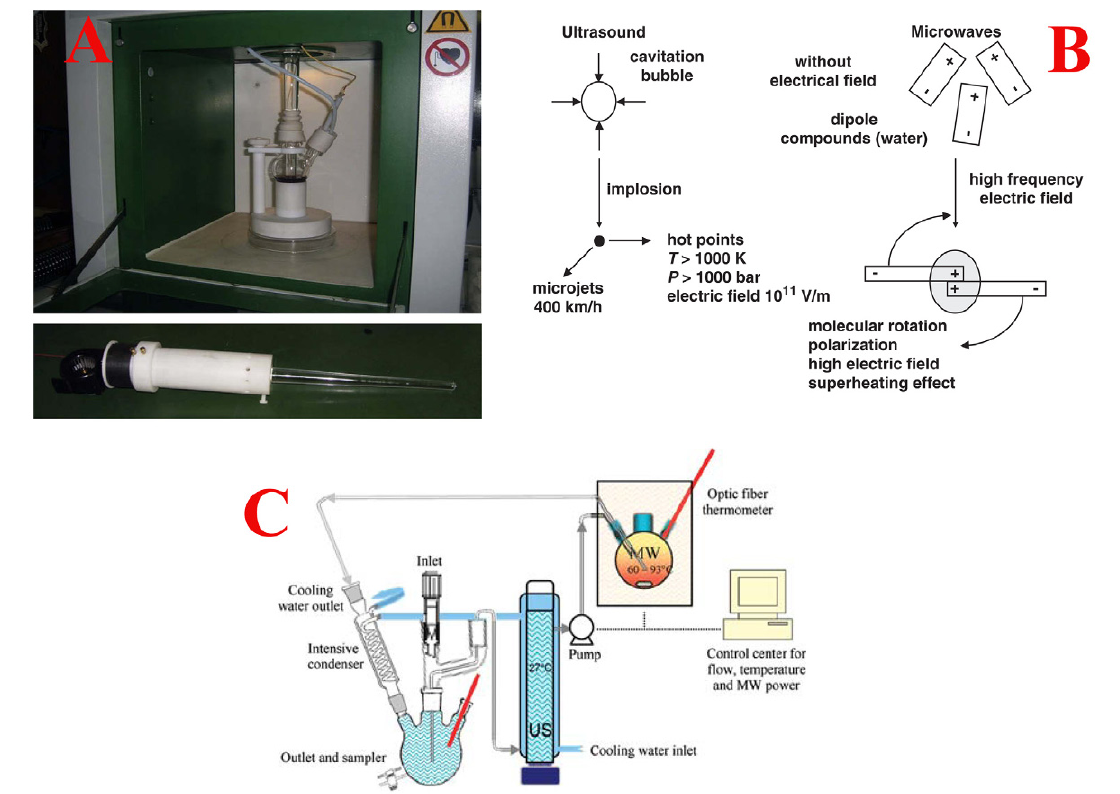
Figure 6. (A) A typical simultaneous and direct MW/US irradiation instrument (top) and US horn made of pyrex (bottom), (B) analogy between ultrasound cavitation and microwave heating and (C) circulating set-up using combined microwaves and ultrasound (reproduced with permission of Elsevier and ACS [